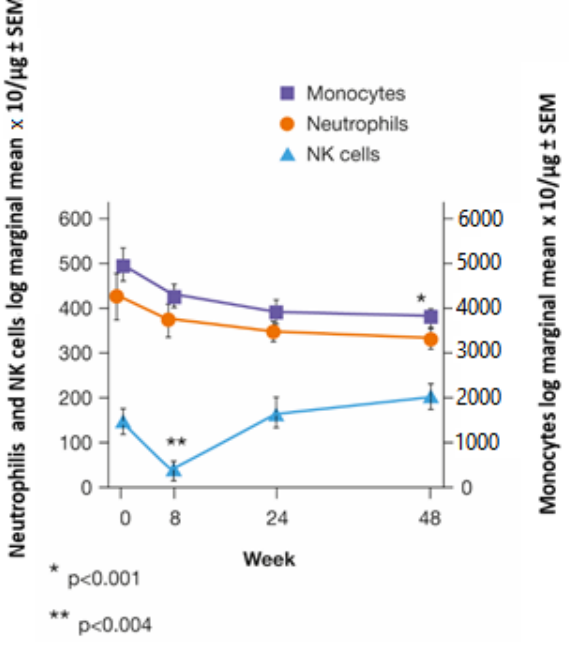
Figure 2. Trends in T lymphocyte subpopulations in 33 patients at specific times after starting cladribine therapy; generalised linear mixed model (* p < 0.001 and ** p = 0.001).